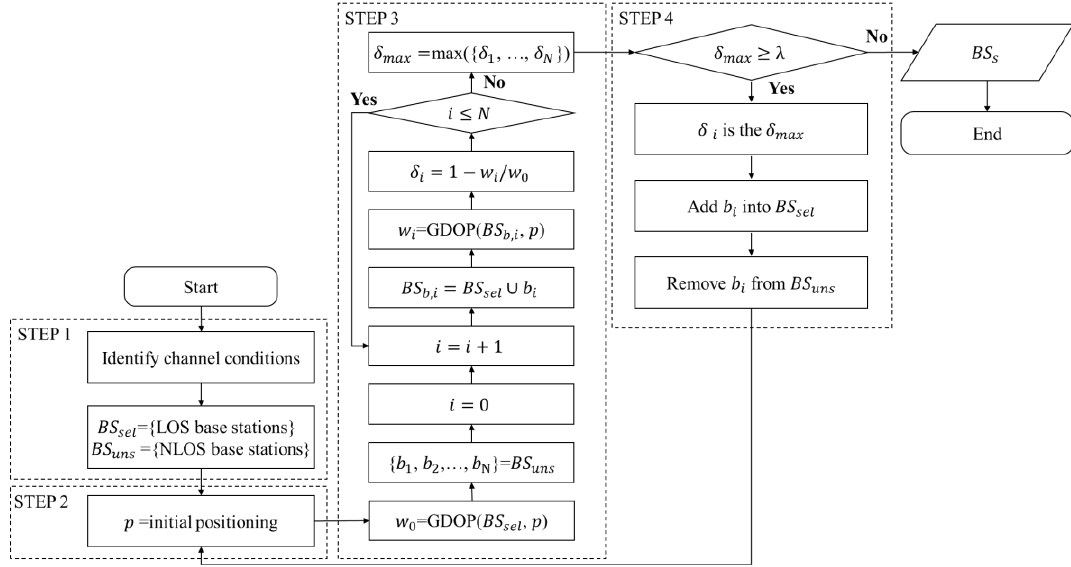
Figure 3. The flowchart of geometric dilution of precision (GDOP)-assisted BS selection method.